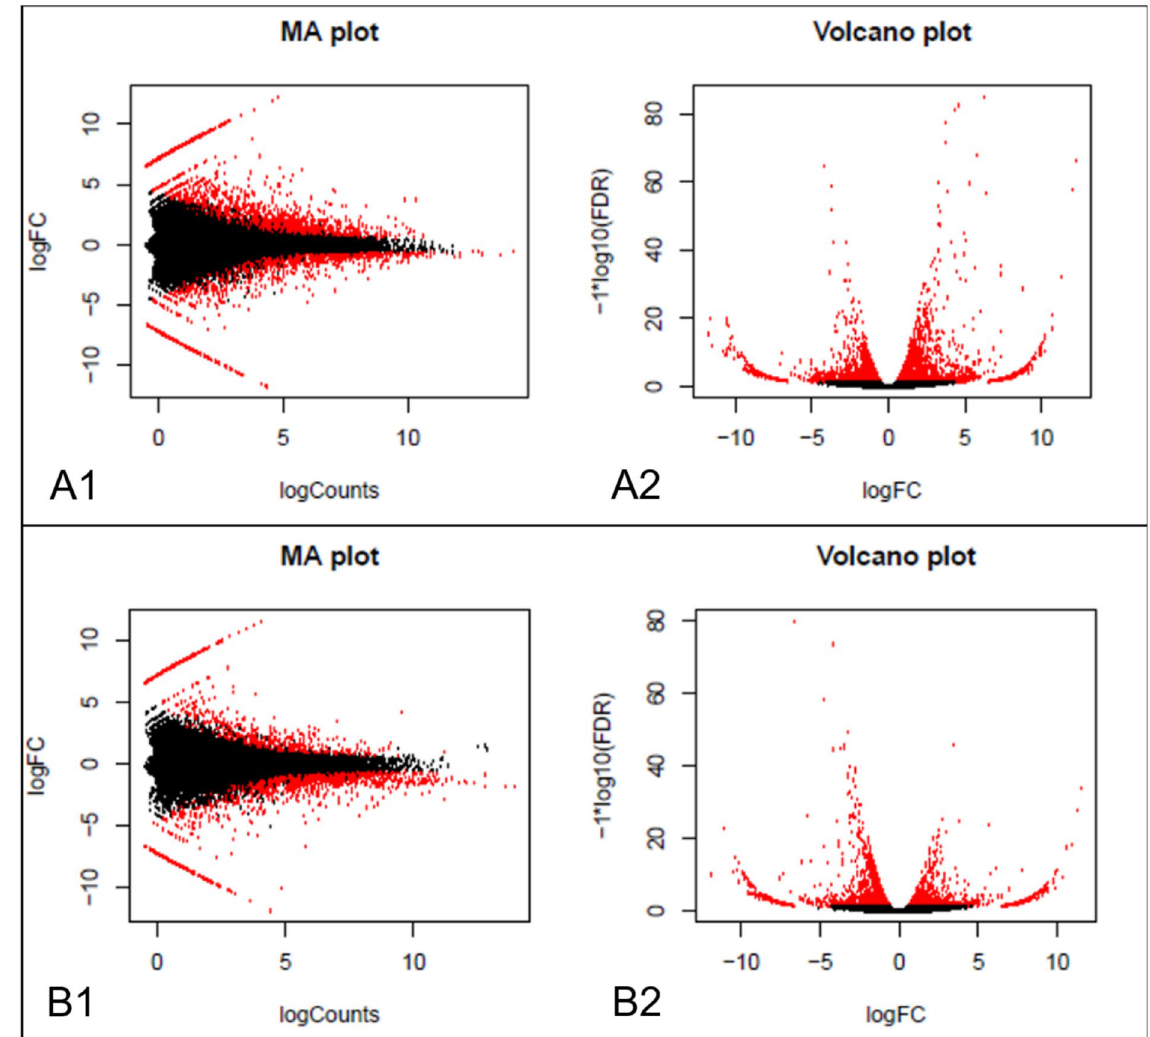
Figure 2. MA and volcano plots representing differentially expressed transcripts. The black dots in the MA plot represent transcripts with similar expression levels, whereas the red dots show significantly up-and down- regulated transcripts. ( A1 & A2 ): Differential expression between blue and white light treatment;( B1 & B2 ): Differential expression between red and white light treatment; ( A1 & B1) . MA plots; ( A2 & B2 ): Volcano their best-matched SwissProt sequences is provided in Table 5. Furthermore, a total of 1751 transcripts were significantly differentially expressed (upregulated: 547; downregulated: 1204) between lettuce grown under red and white light. Table 6 provides a list of top 20 differentially expressed transcripts and their best-matched Swis- sProt sequences. Interestingly, the highest number (2745 transcripts) of differentially expressed transcripts were found when leaf RNA samples from plants grown under blue and red light were compared. Among these, 1741 transcripts were upregulated, whereas 1004 transcripts were downregulated in plants grown under blue light compared to red light. A complete list of significantly differentially expressed transcripts across all comparisons can be found in Supplementary file 3. An MA-plot shows log-fold change (M-values) in the log of the ratio of level counts for each gene between the RNA samples from lettuce grown under blue and white light (Fig. 2A) or red and white light (Fig. 2B) against the log-average (A-values, i.e., the average level counts for each gene across the two samples). The heatmap constructed using differentially expressed transcripts in lettuce grown under blue or red or white light treatment showed a clear clustering of the samples of the same groups (Fig. 3). Validation of differentially expressed transcripts. A total of 28 significantly differentially expressed transcripts were considered for validation using RT-qPCR. However, one transcript, TRINITY_DN17554_c0_ g6_i2 was excluded as it showed multiple bands. All 27 transcripts when tested using RT-qPCR analysis, showed complete agreement with the RNA sequencing data. The transcripts were differentially expressed with a mini- mum |log2 fold|> 2 according to RT-qPCR (Table 7).